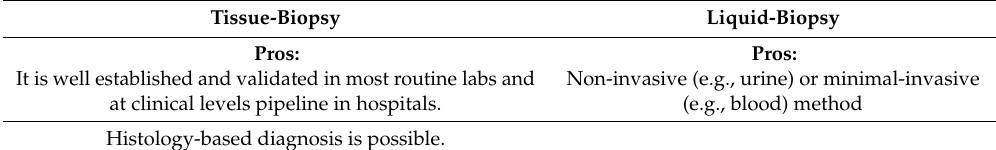
Figure 1. Liquid biopsies in the management of colorectal cancer (CRC). Disease specific circulating free DNA (cfDNA), circular RNAs (circRNAs), long-non coding RNA (lncRNAs), microRNAs, and circulating tumour cells (CTCs) are present in the blood of a colon cancer patient. Analysis of nucleic-acids isolated from a blood sample can be performed by di ff erent molecular biological methods such as microarrays, NanoString technology, digital droplet PCR (ddPCR), or next-generation sequencing (NGS). Table 1. Overview about advantages and disadvantages of the two biopsy forms.